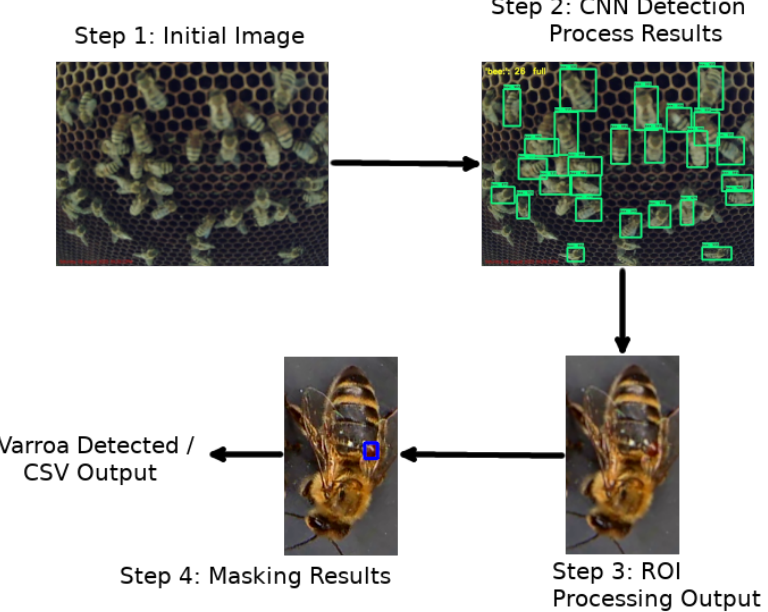
Figure 3. Proposed algorithm step-by-step detection output per flowchart detection process